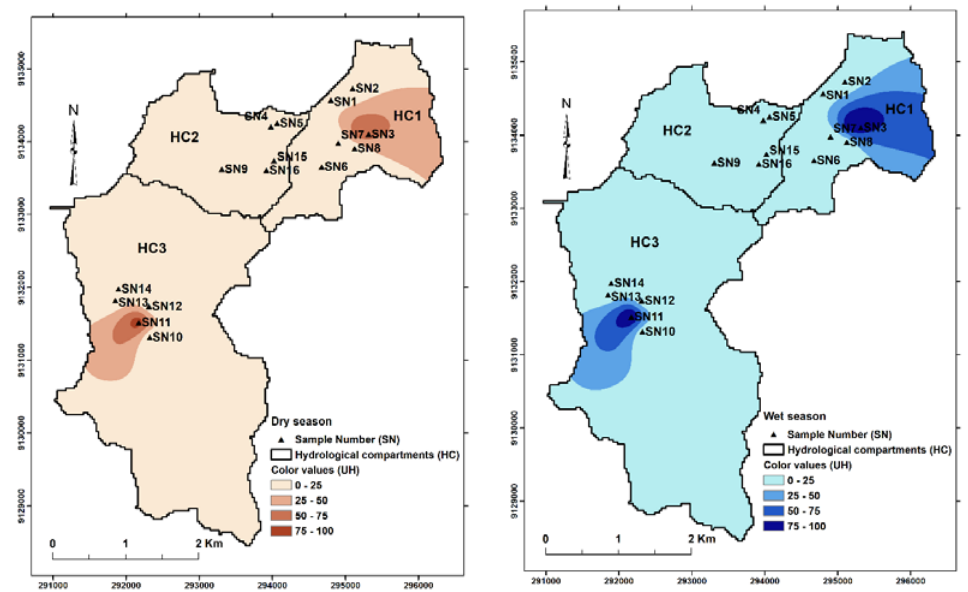
Figure 5. Spatial distribution of color on the dry and wet seasons in the three hydrological